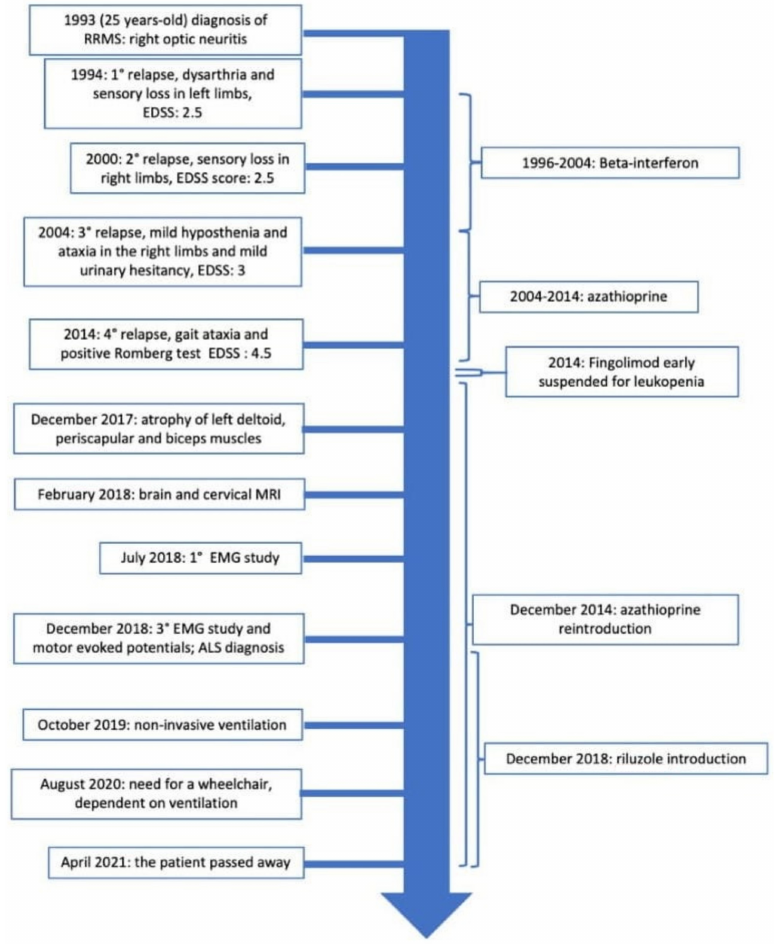
Figure 2. Timeline of the patients